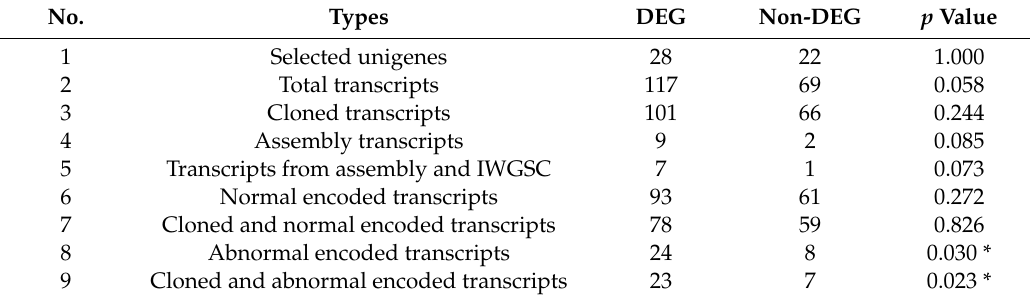
Table 2. Conformity test between number of TaNAC transcripts and number of originally selected unigenes, including those classified as di ff erentially expressed (DE) and non-DE under fungal stress.